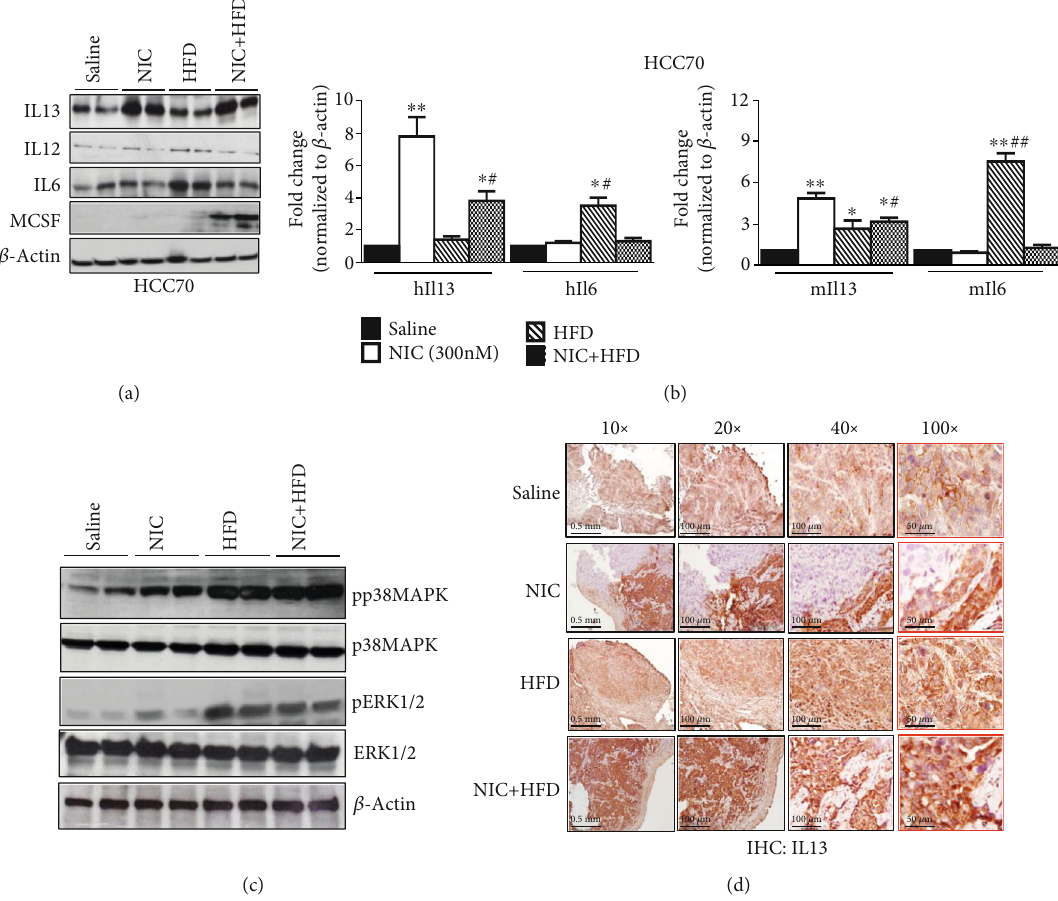
Figure 2: Increased expression of anti-in fl ammatory cytokines in xenografts exposed to either NIC or NIC+HFD. (a) Western blot analysis of cytokines IL13, IL12, IL6, and MCSF in HCC70 xenografts obtained from various treatment groups. β -Actin was used as control. (b) Quantitative gene expression analysis of IL13 and IL6 in HCC70 xenografts from various treatment groups, using human- (right panel) and mouse- (left panel) speci fi c primer sets. (c) Western blot analysis of p38MAPK and pERK1/2 in xenografts obtained from various treatment groups. (d) Immunohistochemical (IHC) analysis of IL13 expression in xenografts obtained from various treatment groups. ∗ p ≤ 0 : 05 and ∗∗ p ≤ 0 : 01 compared to saline or # p ≤ 0.05 and ## p ≤ 0.01 compared to the NIC group alone ( n = 3